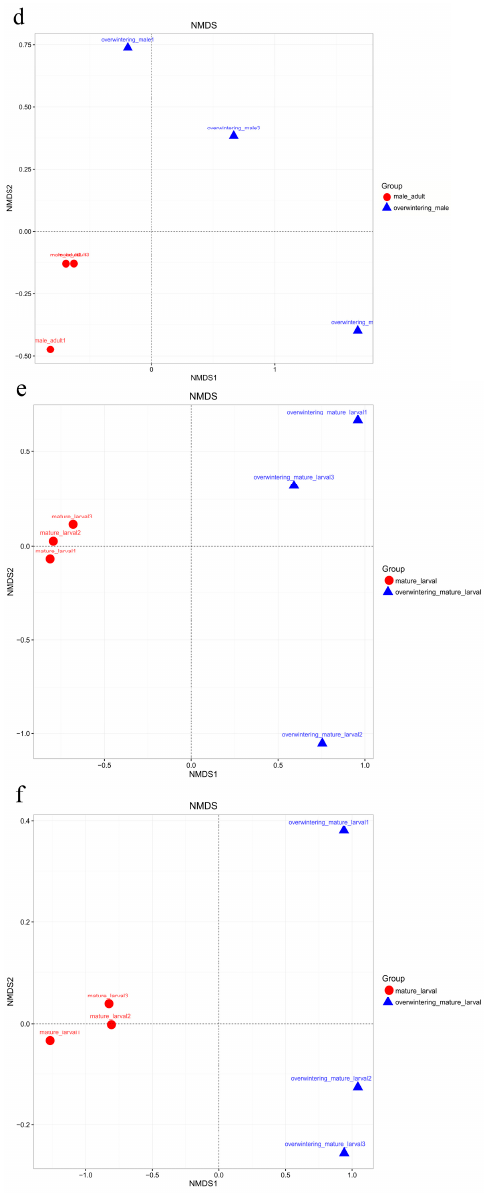
Figure 7. Nonmetric multidimensional scaling analysis of the Bray–Curtis dissimilarity index of the fungal community OTUs ( ≥ 97% identity) in different generations of T. klimeschi based on Illumina sequencing of ITS genes. Adult females vs. overwintering adult females: ( a ) Unweighted; ( b ) Weighted; adult males vs. overwintering adult males: ( c ) Unweighted; ( d ) Weighted; mature larvae vs. overwintering mature larvae: ( e ) Unweighted; ( f )